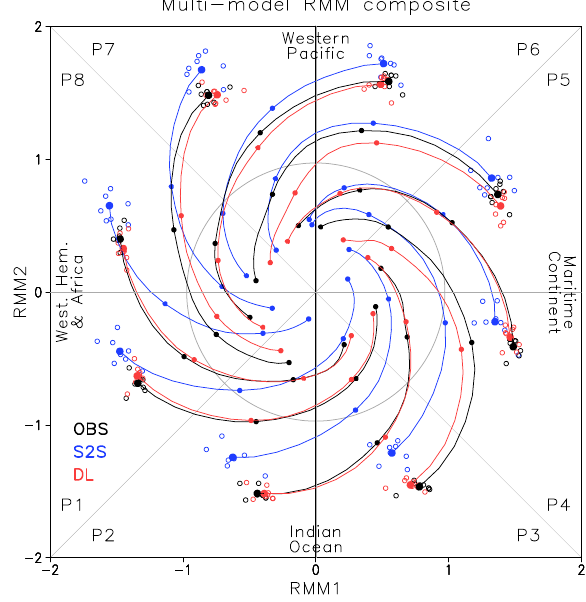
Fig. 1 Observed and predicted Madden-Julian oscillation (MJO) composites. Multi-model means of the Real-time Multivariate MJO indices (RMMs) composite on the phase-space diagram in eight MJO phases for observations (black), Subseasonal-to-seasonal (S2S) reforecasts (blue), and Deep learning (DL) corrections (red). Forecasts on day 1 by the eight individual models are depicted as open circles and multi-model means as large closed circles. Small closed circles represent seven-day intervals from day 1. A three-day moving average is applied. Note that Fig. 1 is an average of individual model composite shown in Supplementary Fig.